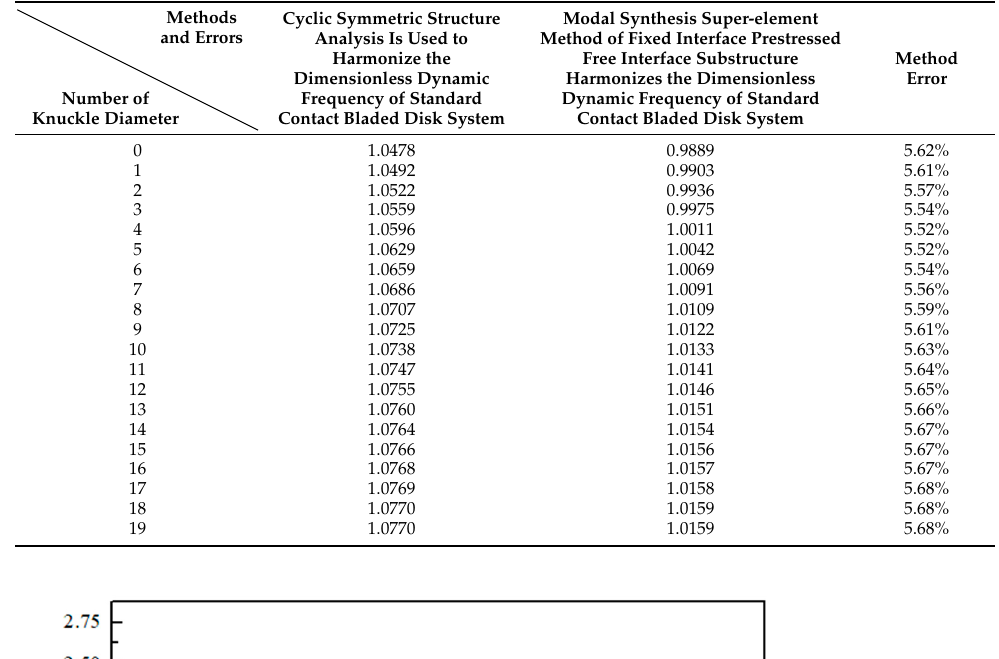
Table 1. Accuracy verification of the modal synthesis super-element method for the prestressed and free interfacial substructures with fixed interfaces.